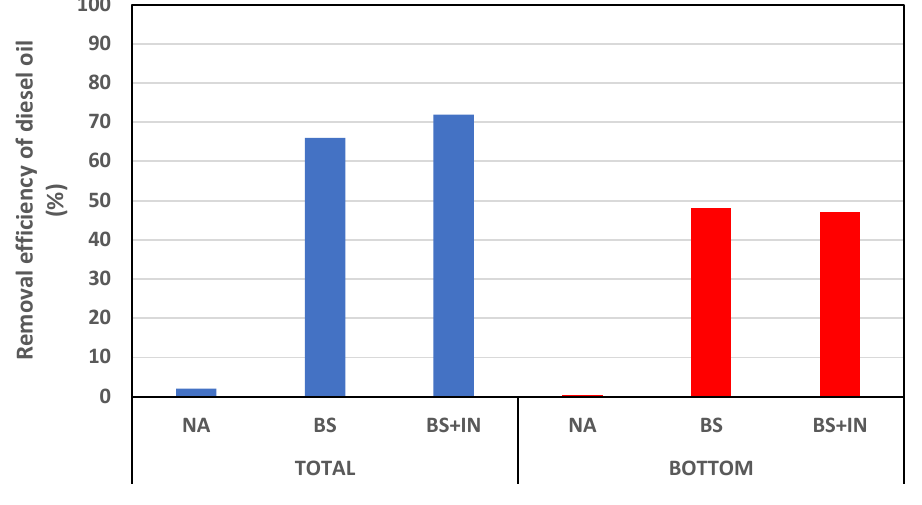
Figure 7. Diesel oil removal efficiency at t = 228 days for BS and BS + IN, and at t = 193 days for NA.